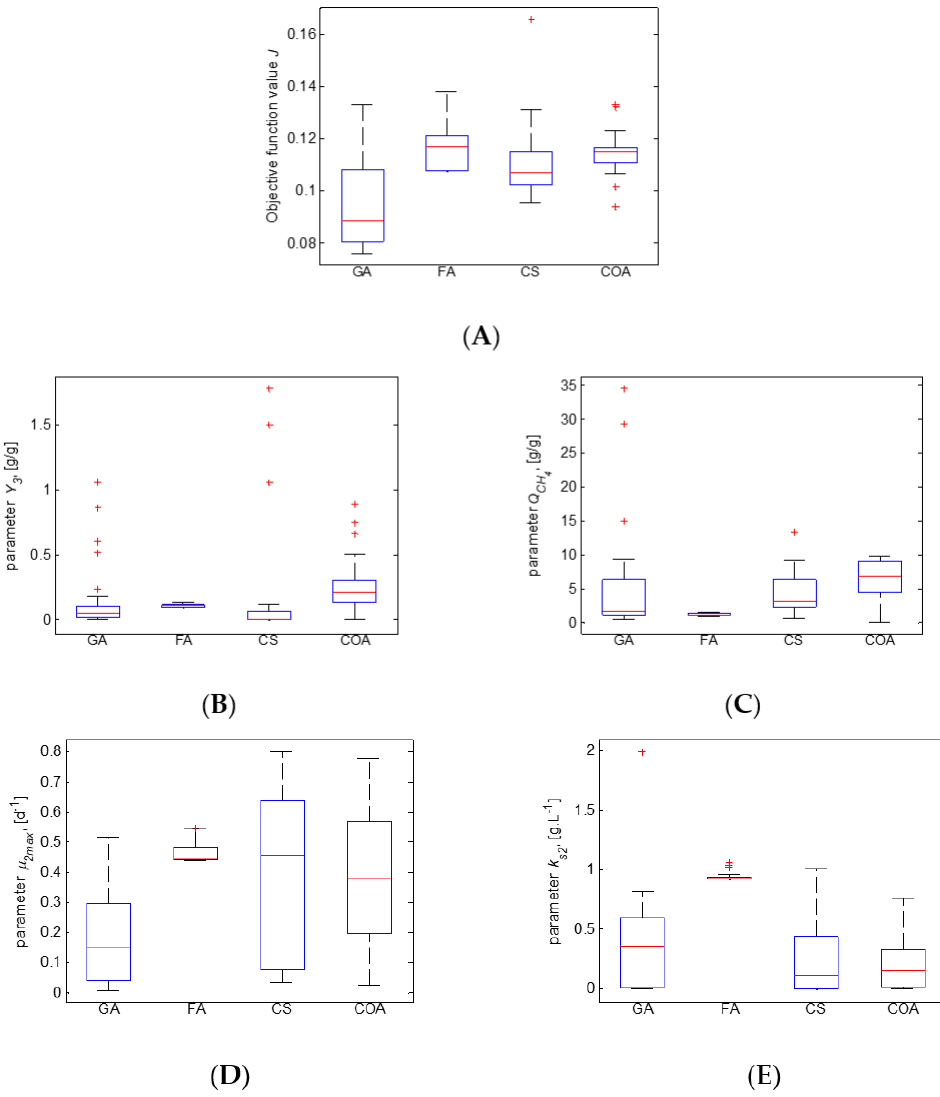
Figure 3. Box plot for the results of the second identification step. ( A ) objective function J 2 ; ( B ) pa- rameter Y 3 ; ( C ) parameter Y CH ; ( D ) parameter µ 2 max ; ( E ) parameter K S 4